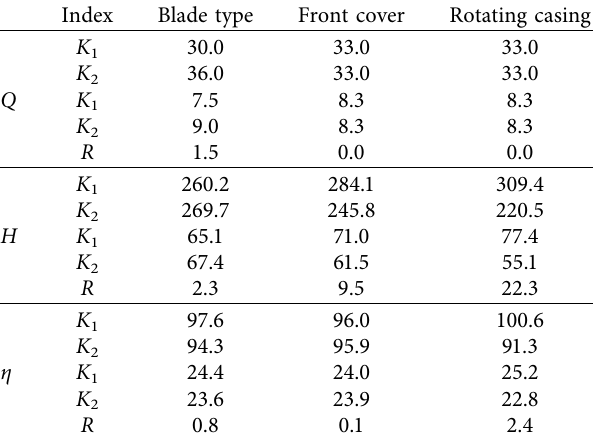
Table 4: Flow and head analysis at the highest efficiency